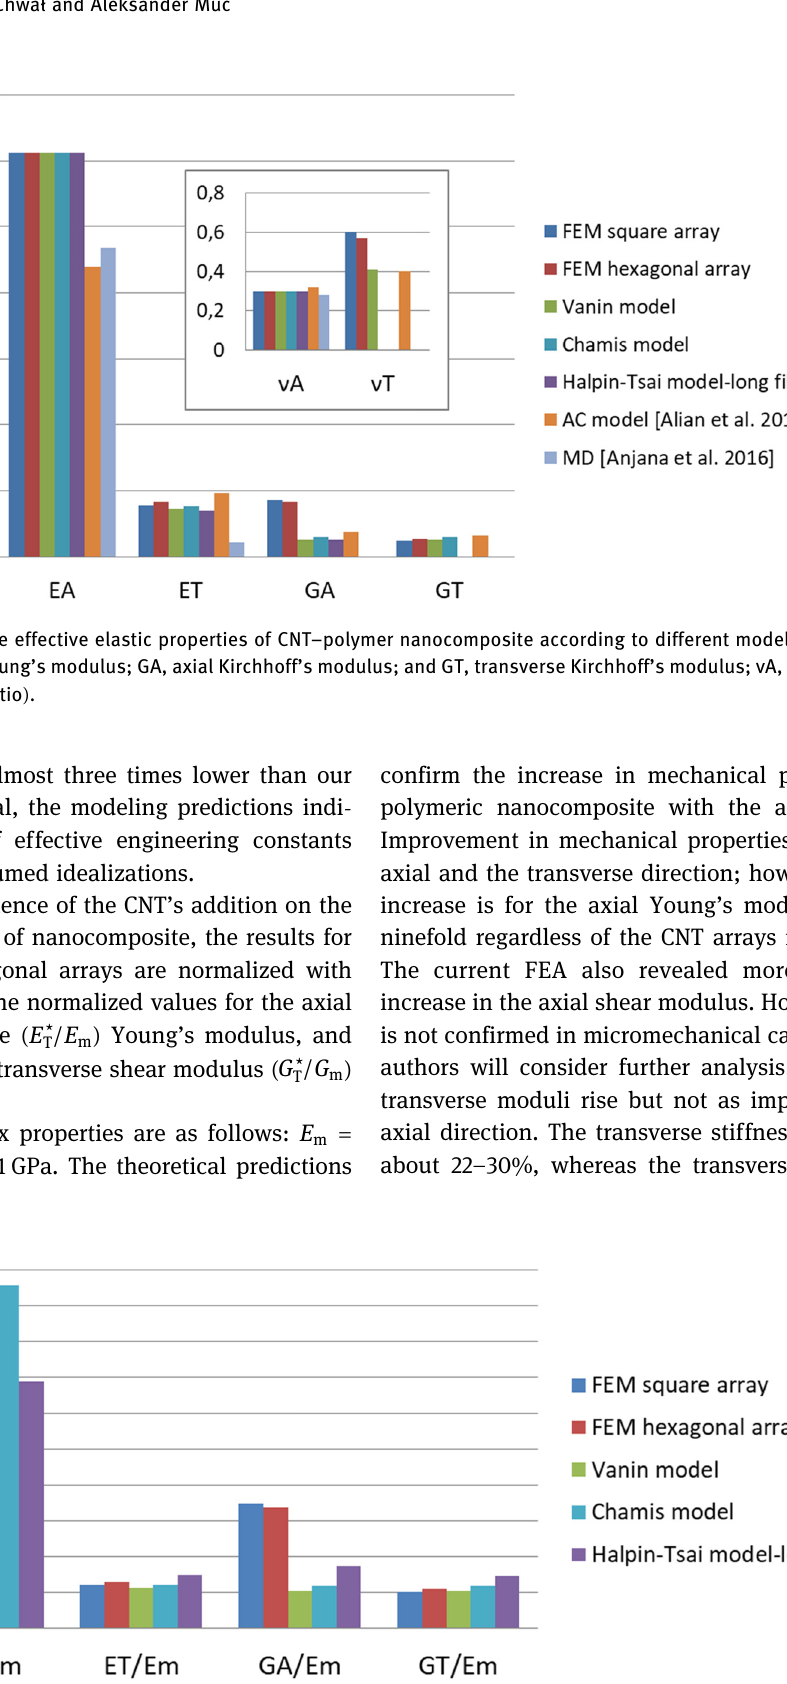
Figure 6: Comparison of the normalized moduli of the CNT/polymer